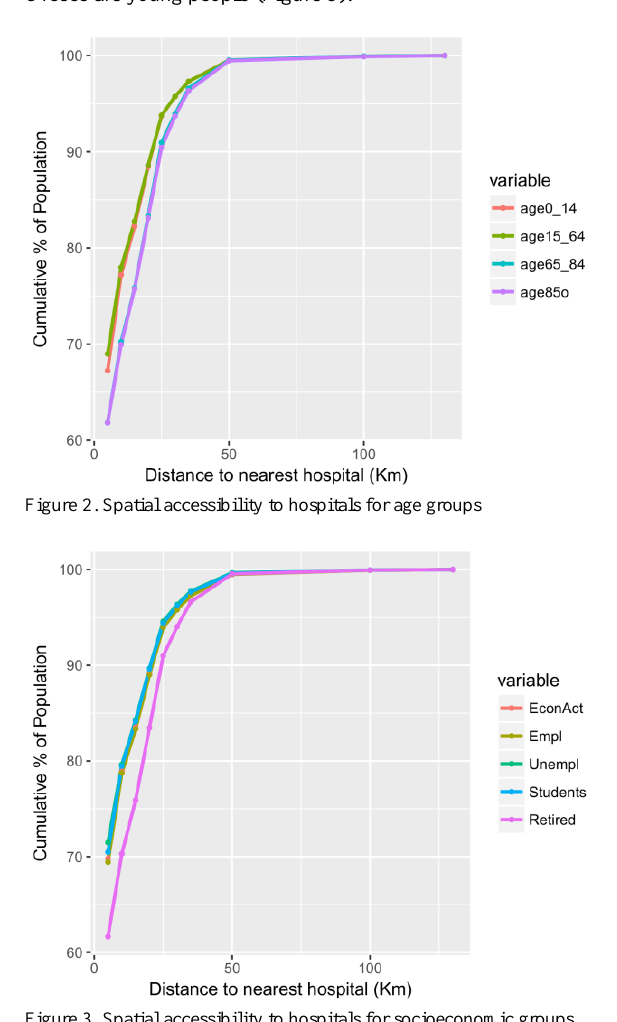
Figure 3. Spatial accessibility to hospitals for socioeconomic groups